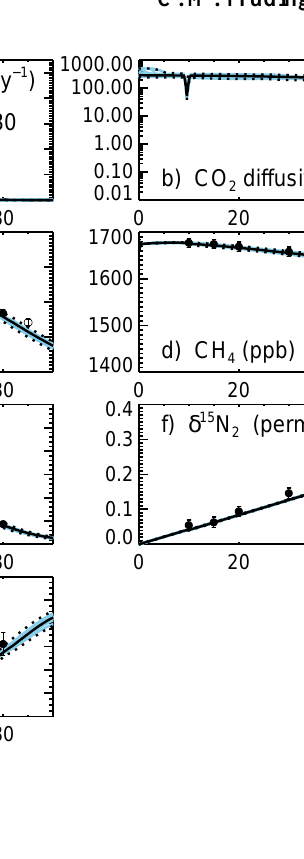
solutions with 8 W up to 1.17 corresponding to a confidence level of 68